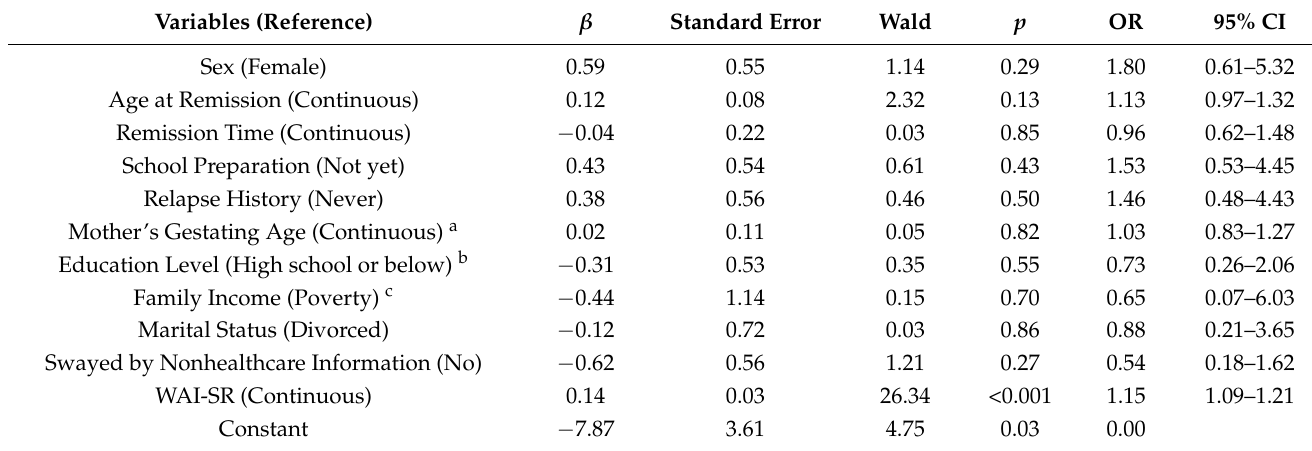
Table 3. Multivariable logistic regression of vaccine acceptance in CALLS parents recommended to receive